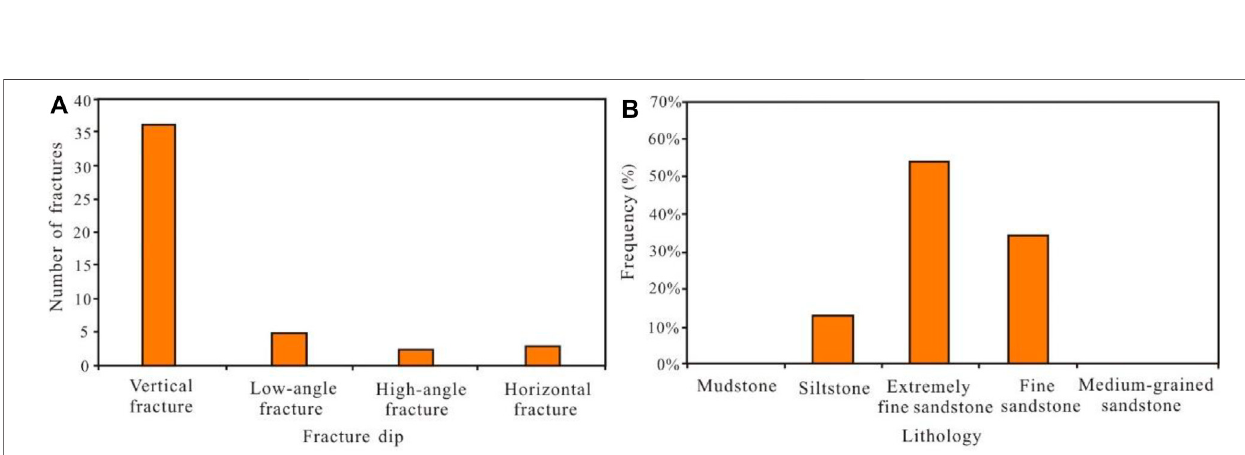
Frontiers in Earth Science |